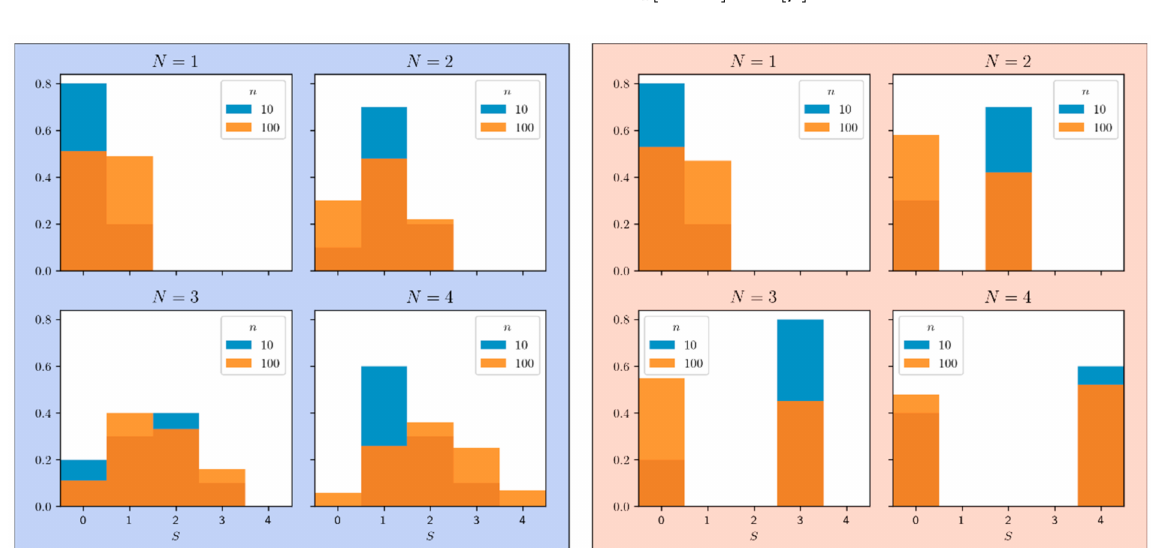
Figure 1. Simulated histograms of gains S for two distributions f 0 and f 1 : on the left-hand side f 0 ( p ) = δ ( p − 1/2 ) and on [ δ ( p ) + δ ( 1 − p )] . In each case, the histogram of success is plotted for increasing values of the the right-hand side f 1 ( p ) = 1 2 number N of draws ( N = 1,2,3,4) and for two numbers n of gamblers: n = 10 (in blue) and 100 (in orange). For N = 1, note that the histogram for f 0 is similar to the histogram for f 1 and both histograms converge to the same limit as n goes to infinity. On the contrary, for each N ≥ 2, the histograms for f 0 and f 1 diverge as n